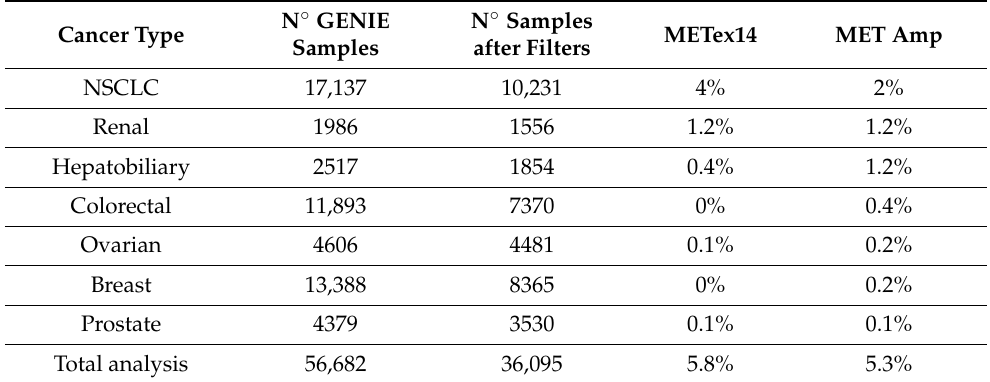
Table 1. METex14 and METamp frequency in NSCLC, renal, hepatobiliary, colorectal, ovarian, breast, and prostate cancers in the GENIE cohort [13]. Germinal mutations, uncertain significance variants, and patients missing MET analysis were filtered out using available tools at https://genie.cbioportal. org/ (last time accessed on 10 November